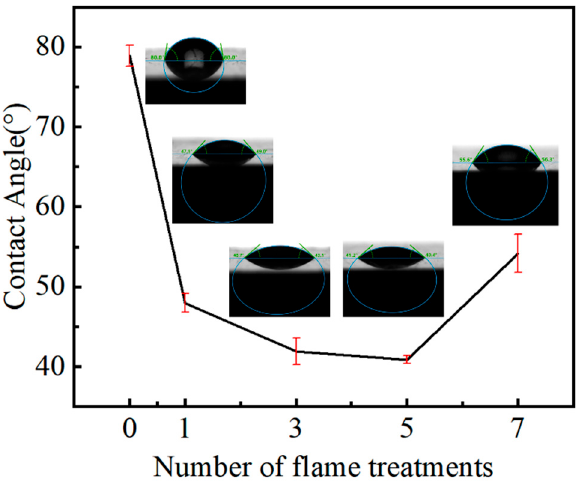
Figure 15. Contact angle test.